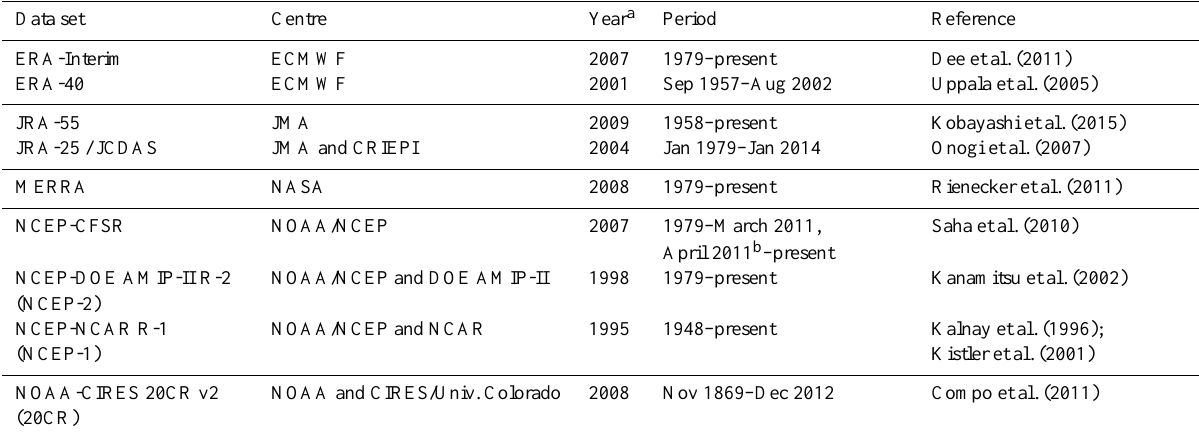
Table 1. List of global atmospheric reanalysis data sets considered in this study. Data